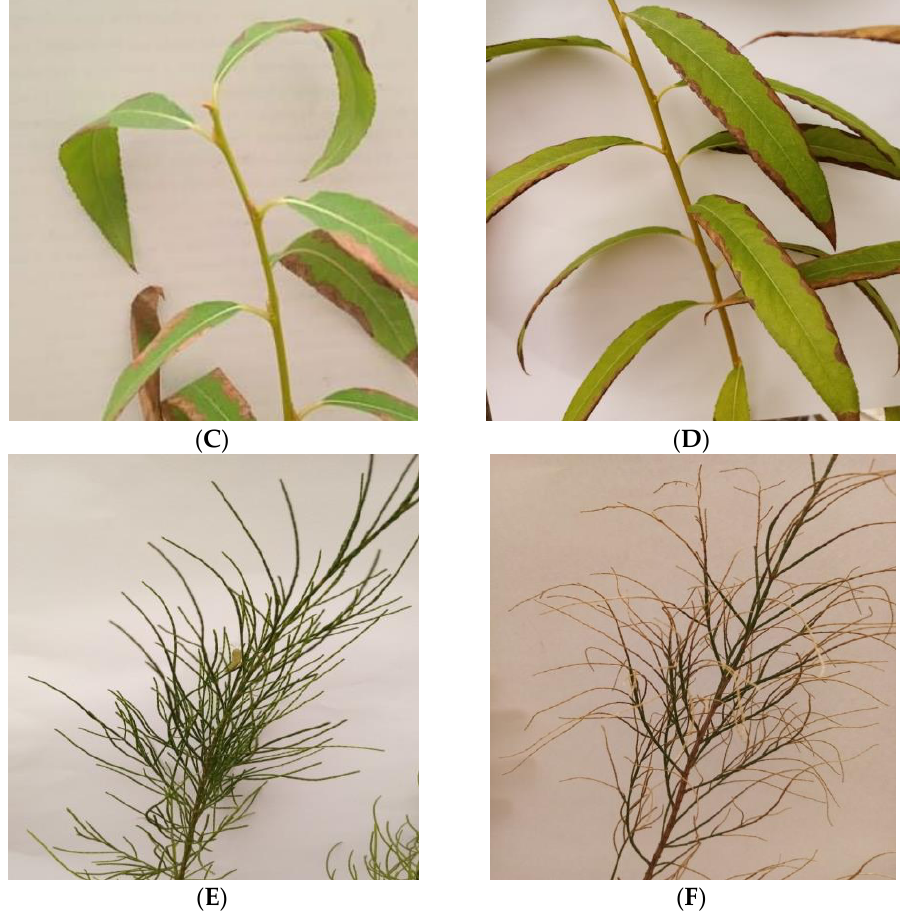
Figure 1. Appearance of chlorosis ( A ) and necrotic areas on the edges of the limbus ( B ), leaf rolling ( C ) and epinasty ( D ) after 6 days in seedlings of S. alba treated with 25% industrial wastewater (25% IWW) compared to control ( A ), and desiccation of the needles of C. glauca treated with 25% IWW after 15 days ( F ) compared to control ( E ).